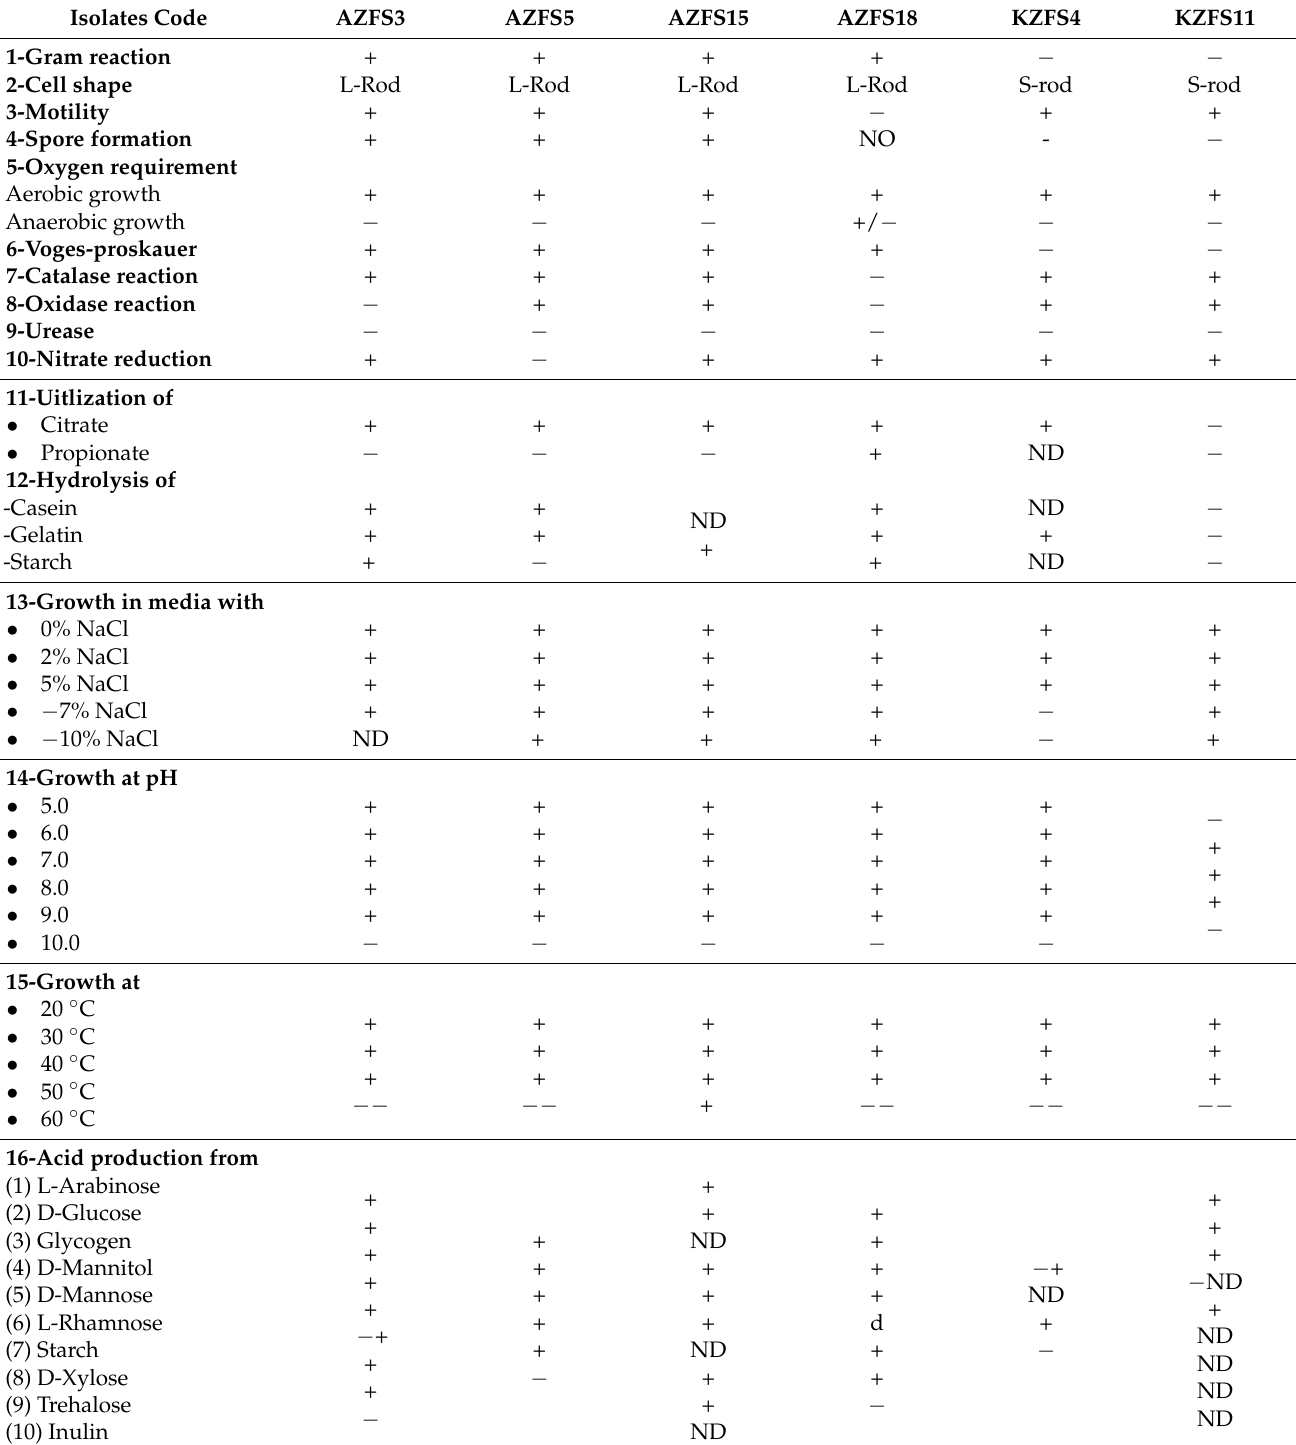
Table 2. Morphological, physiological, and biochemical characteristics of the selected six active pesticide-degrading bacterial